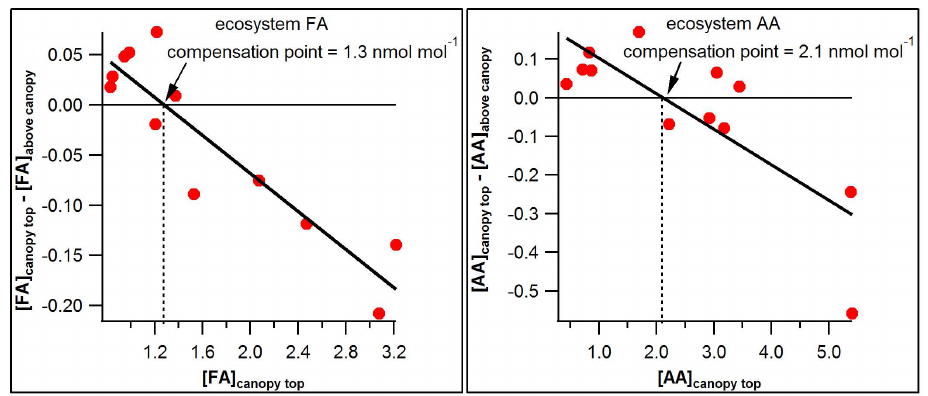
Fig. 4. Ecosystem scale compensation point estimates for FA and AA. The exchange driver, the average concentration difference (nmolmol − 1 ) between the top of the canopy (30m) and above the canopy (40m) are plotted versus the concentration (nmolmol − 1 ) at the top of the canopy. Canopy emission are indicated by positive values and deposition by negative values and the compensation point is defined as the ambient concentration (nmolmol − 1 ) at the top of the canopy where the concentration difference, and therefore the exchange flux is zero